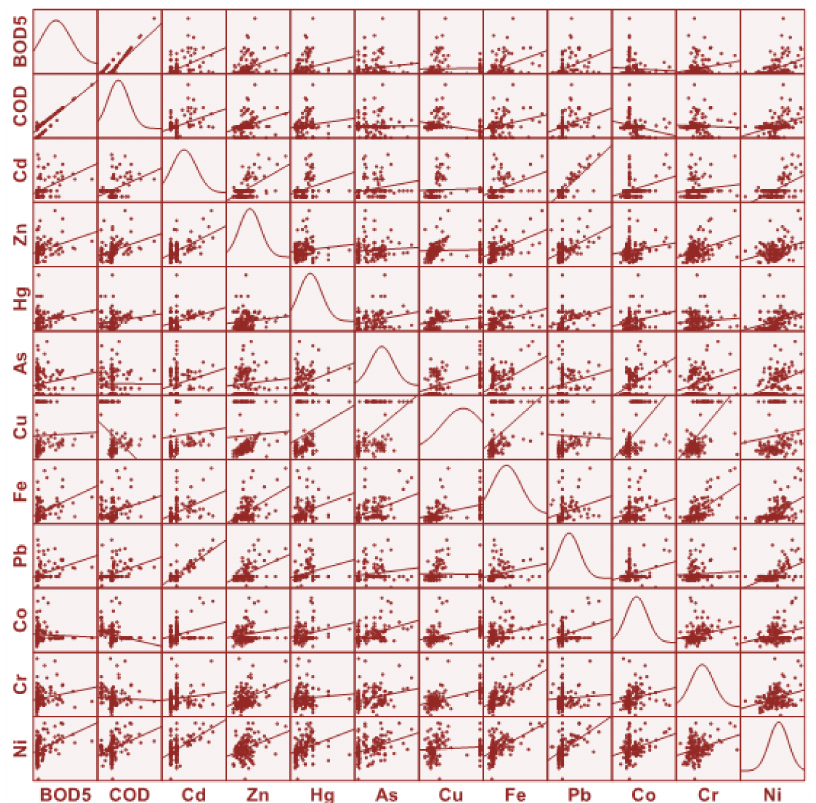
Figure 4. Pearson’s correlation matrix between chemical characteristics of treated leachate during the study